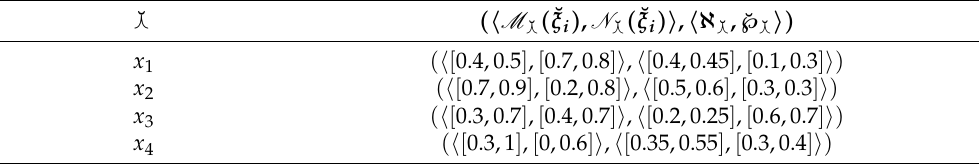
Table 3. IVLDFS for screen